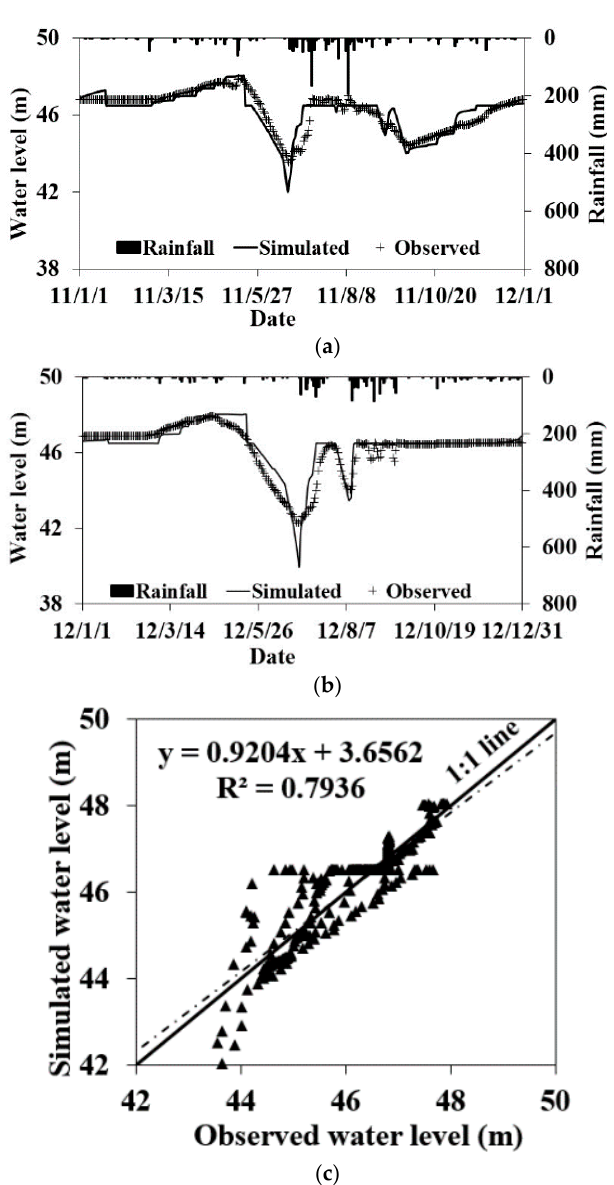
Figure 9. Comparison of the observed to the simulated reservoir water levels for ( a ) the calibration; ( b ) validation periods; and ( c ) 1:1 line plot between the simulated and observed water levels. The dashed line represents a least square regression line.